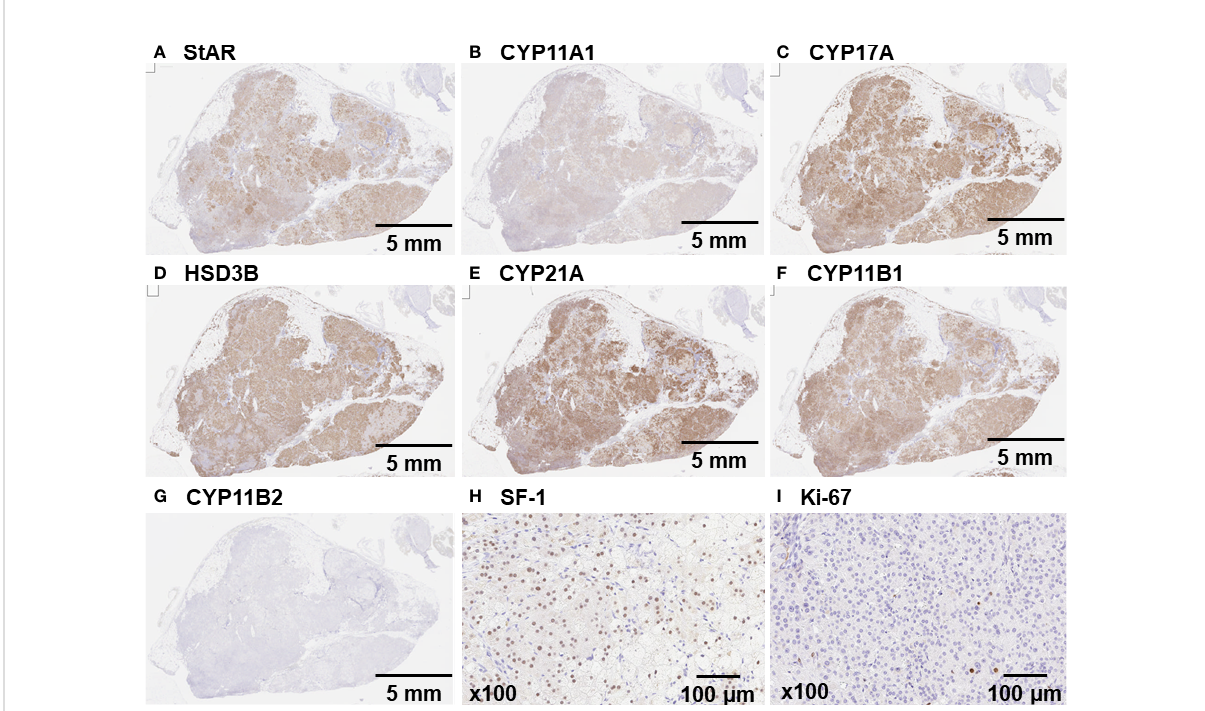
FIGURE 2 Immunohistochemical staining of the tumor on the right renal hilum Immunohistochemical staining con fi rmed a pituitary adenoma that was markedly positive for (A) StAR, (B) CYP11A1, (C) CYP17A, (D) HSD3B, (E) CYP21A, (F) CYP11B1, and (H) SF-1. (G and I) Staining for CYP11B2 and Ki-67 was